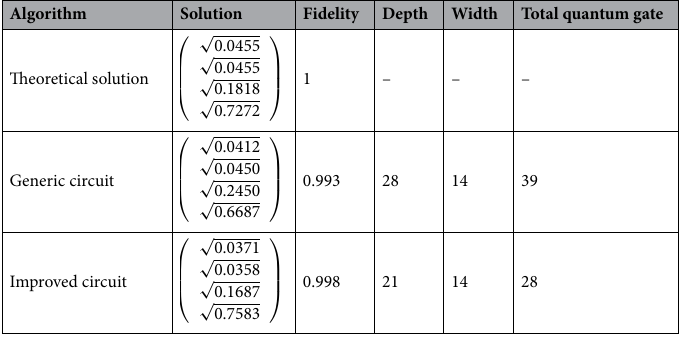
Table 1. Comparison of simulative and theoretical solutions of 4 circuits to implement the HHL algorithm to solve the linear equation system, the fidelity of the experimental solution cannot reach 1 due to current technical